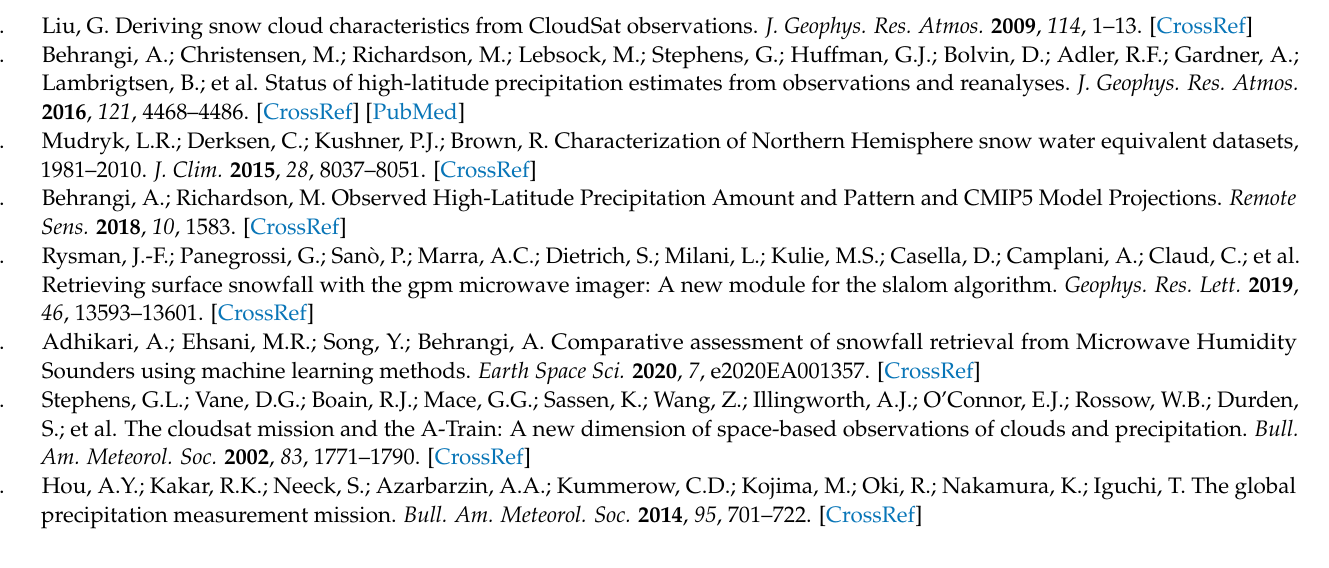
Figure A1. Box and whisker plots describing the PE distributions between complete and subsampled CFDDA precipitation reanalysis estimates at different spatial resolutions for 10 ( a ), 20 ( b ), 30 ( c ) and 90 ( d ) day time periods The middle line representing the median PE , the box edges represent the first and third quartile, and the edges of the “whiskers” are extended 1.5 times the interquartile range beyond the first and third quartiles. Measurements beyond the whiskers are represented as “fliers”.